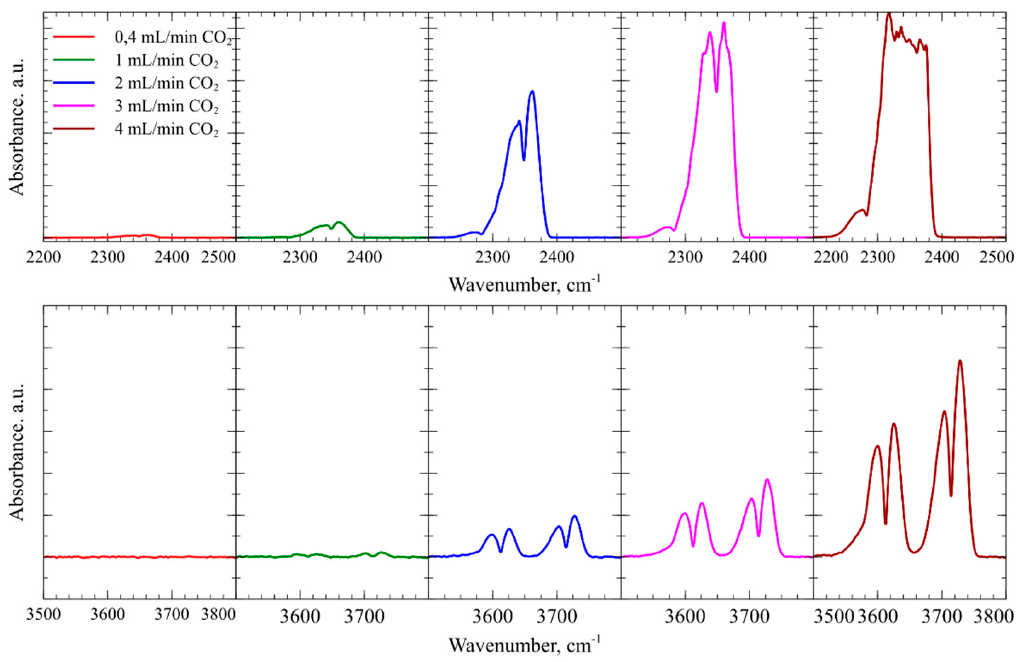
Figure 10. Fourier Transform Infrared spectroscopy data peaks formed at wavenumbers in region 2200 to 2500 cm − 1 and region 3500 to 3800 cm − 1 produced by absorbance of CO 2 phase molecules.